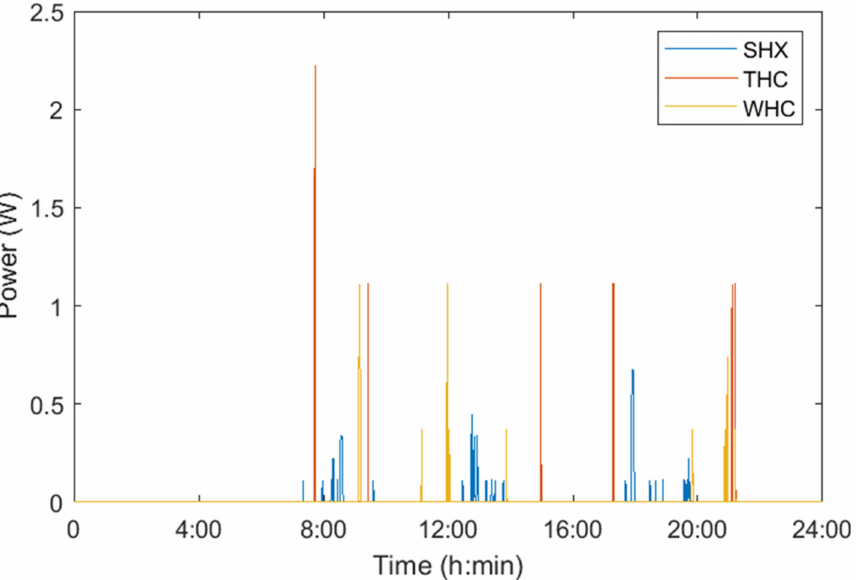
Figure 2. Daily DHW scaled load profile for the single-family house in Jordan during day types SHX, THC and WHC, scaled according to VDI-4655